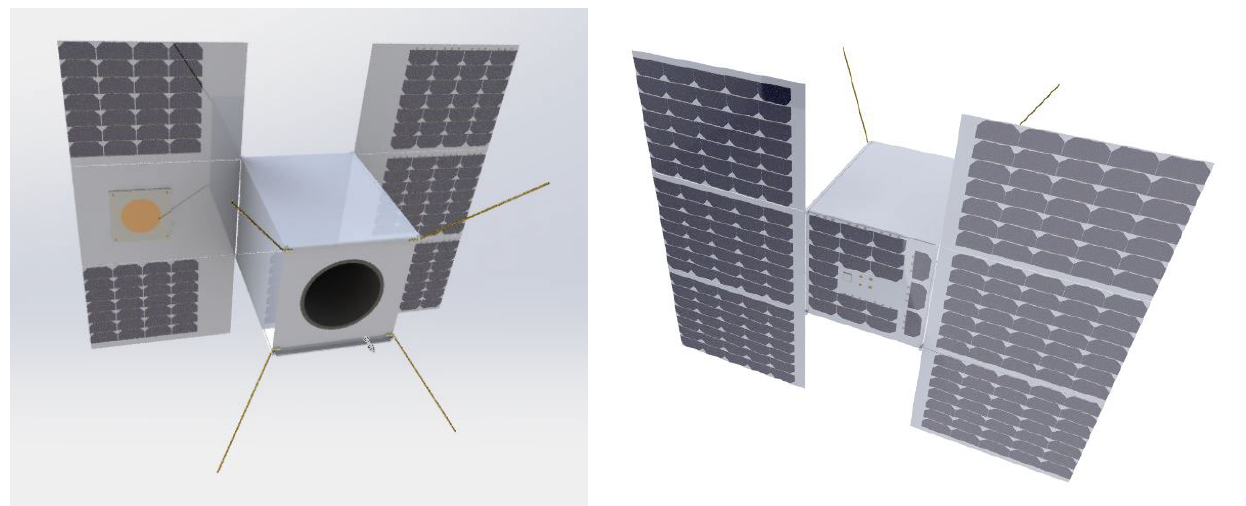
Figure 9. A 3D satellite rendering of the final baseline satellite design.